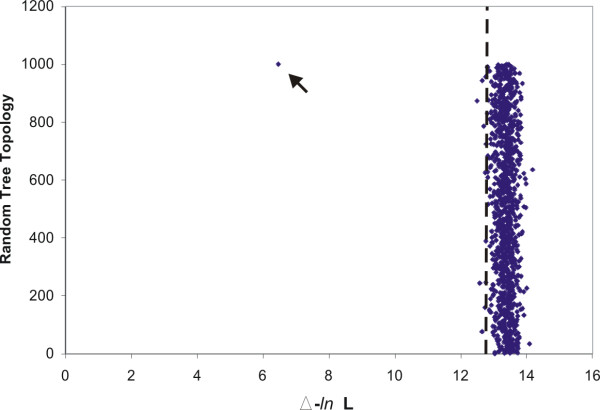
Likelihood analysis of phylogenetic congruence between the bacteriophage TUD phylogeny shown in Figure 4 and random trees. The 99th percentile of the likelihood differences between the TUD tree and the topologies from 1000 random trees is indicated by the vertical dashed line. The position of the TUD phylogeny (indicated by the arrow) is substantially outside of the null distribution.